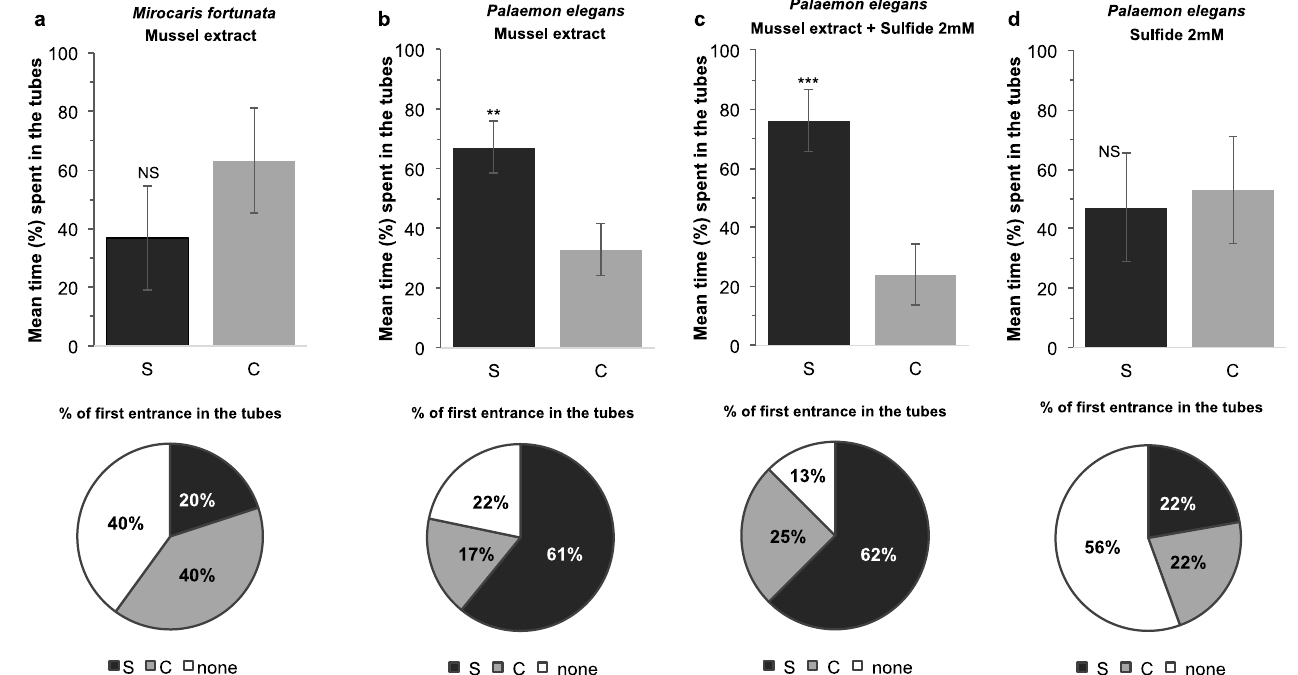
Figure 11. Responses to food and sulfide stimuli during multiple choice experiments on single individuals of Mirocaris fortunata and Palaemon elegans . ( a ) Mirocaris fortunata. Upper graph (bar chart): mean time (% ± S.E.M.) spent in the tube containing the stimulus odor (S, agarose gel loaded with mussel extract, black bar) and in the 3 control tubes (C, agarose gels, grey bar). The means were compared with a two-tailed t-test (not significantly different, n = 10). ( b – d ) Palaemon elegans . Upper graphs (bar charts): mean time (% ± S.E.M.) spent in the tube containing the stimulus odor (S, agarose gel loaded with mussel extract (( b ), n = 23), mussel extract + sulfide 2 mM (( c ), n = 17), sulfide 2 mM (( d ), n = 12), black bar) and in the 3 control tubes (C, agarose gels, grey bar). The means were compared with a two-tailed t-test (( b ), p = 0.008, ** p < 0.01, significantly different; ( c ), p = 0.001, *** p < 0.005, significantly different; ( d ), not significantly different). Lower graphs (pie charts) present the distribution of the shrimp according to their first entrance in the stimulus tube (S, black), a control tube (C, grey) or none (white).